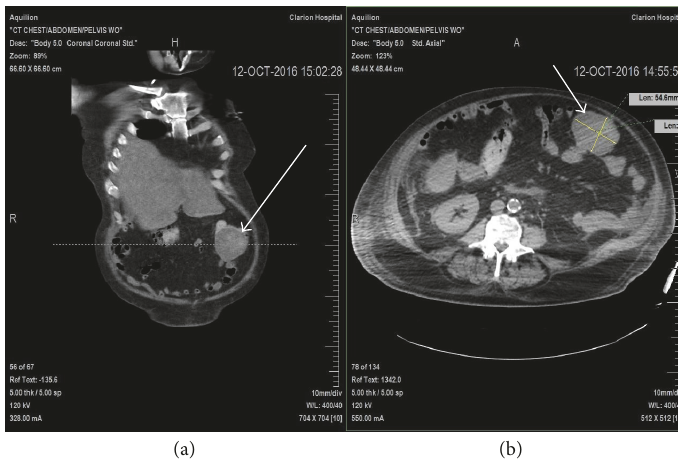
Figure 1: (a) Coronal view of noncontrast CT demonstrating left abdominal wall mass (arrow). (b) Axial view of noncontrast CT demonstrating left abdominal wall mass measuring approximately 7cm × 5.5 cm